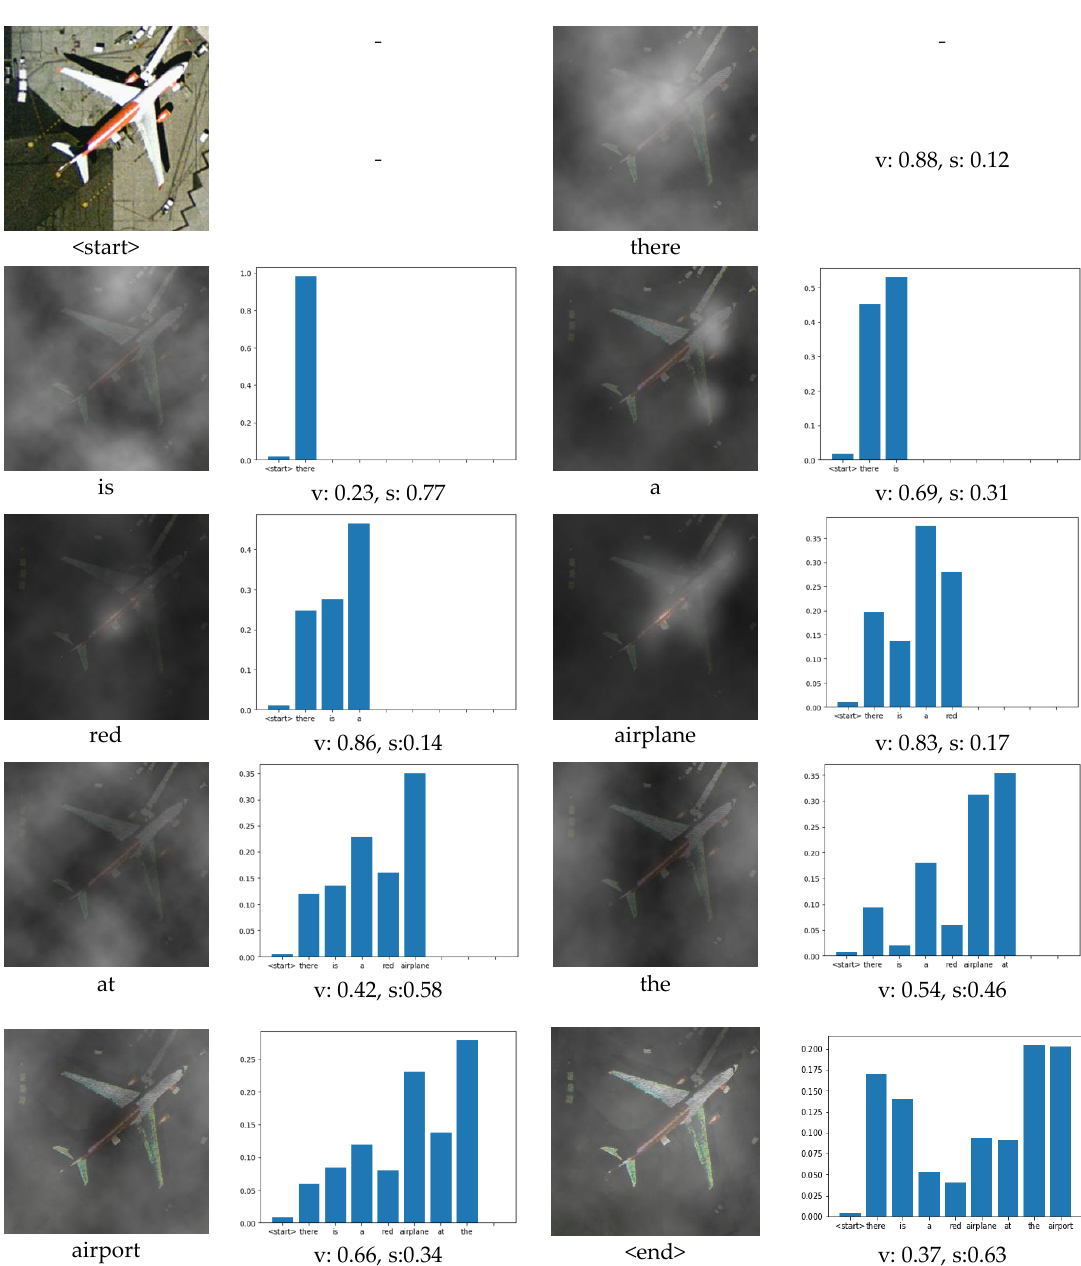
Figure 10. Visualization of our multi-level attention structure when generating the description: "there is a red airplane at the airport". The figure above each word indicates the attention to the image, which is the visualization of the attention1 structure. The brighter the area on the figure, the greater the attention to that area. The blue bar graph indicates attention to the past words when generating the current word, which is the visualization of the attention2 structure. "v" means "visual", and "s" means "semantic". "v: 0.37, s:0.63" means that 37% of attention is visual and 63% of attention is semantic, which is the visualization of the attention3 structure.